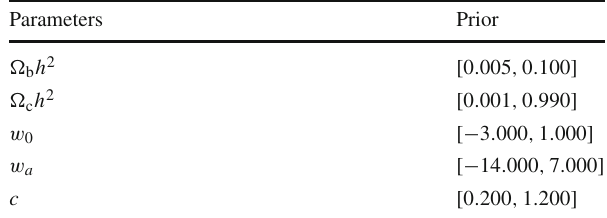
Table 2 Priors on the free parameters for the (cid:2) CDM, w CDM, CPL, and HDE models in a flat